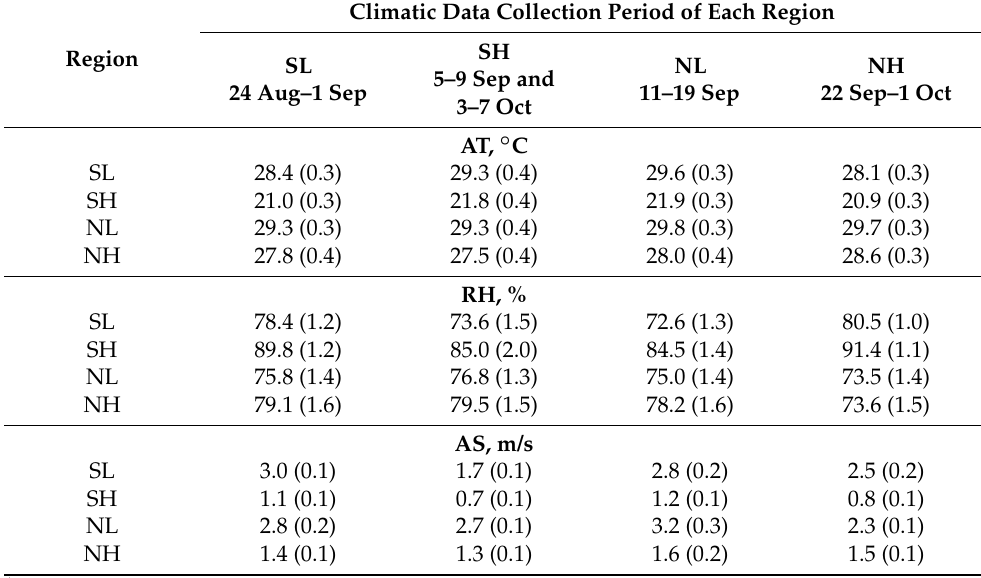
Table 2. Means (SEM) of predicted outdoor temperature (AT), humidity (RH) and air speed (AS) of each region across the dates when the measurements were taken A